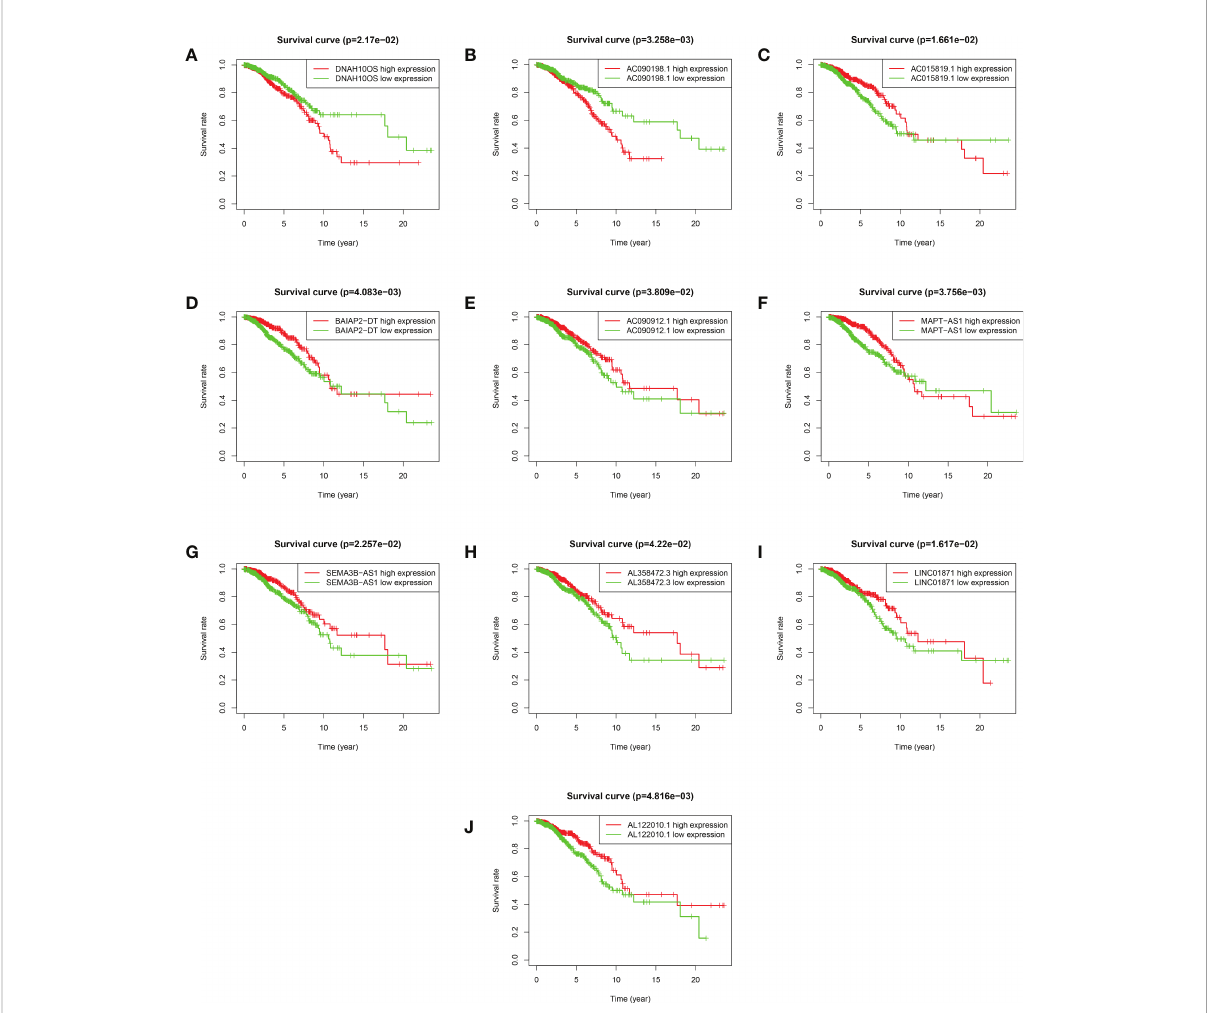
FIGURE 4 Kaplan – Meier survival analyses of 10 ARlncRNAs included in the prognosis model. (A – J) Survival curves of 10 ARlncRNAs and their prognostic value in